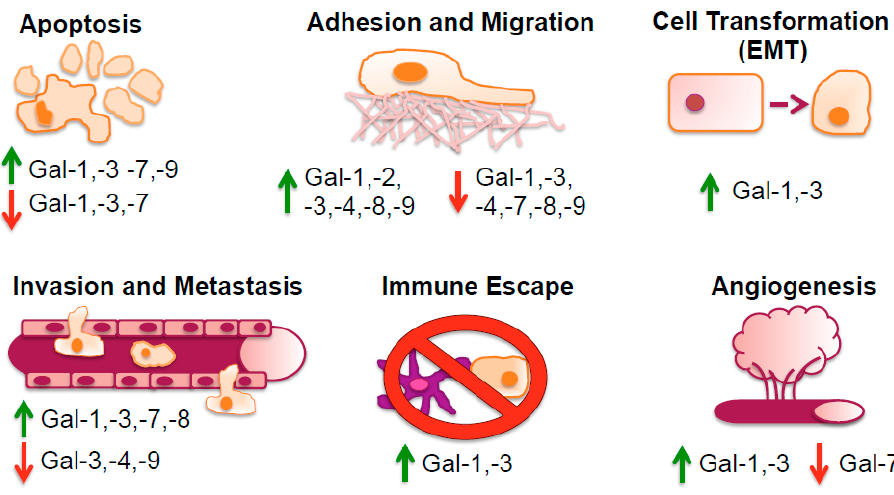
Figure 2. Galectins are involved in multiple processes of cancer initiation and development. A diversity of galectins is associated with key aspects of carcinogenesis, including apoptosis, adhesion and migration, cell transformation (EMT), invasion and metastasis, immune escape, and angiogenesis. Their tentative roles can be pro- and/or anti-tumorigenic, as indicated by green arrows up and red arrows down, respectively.